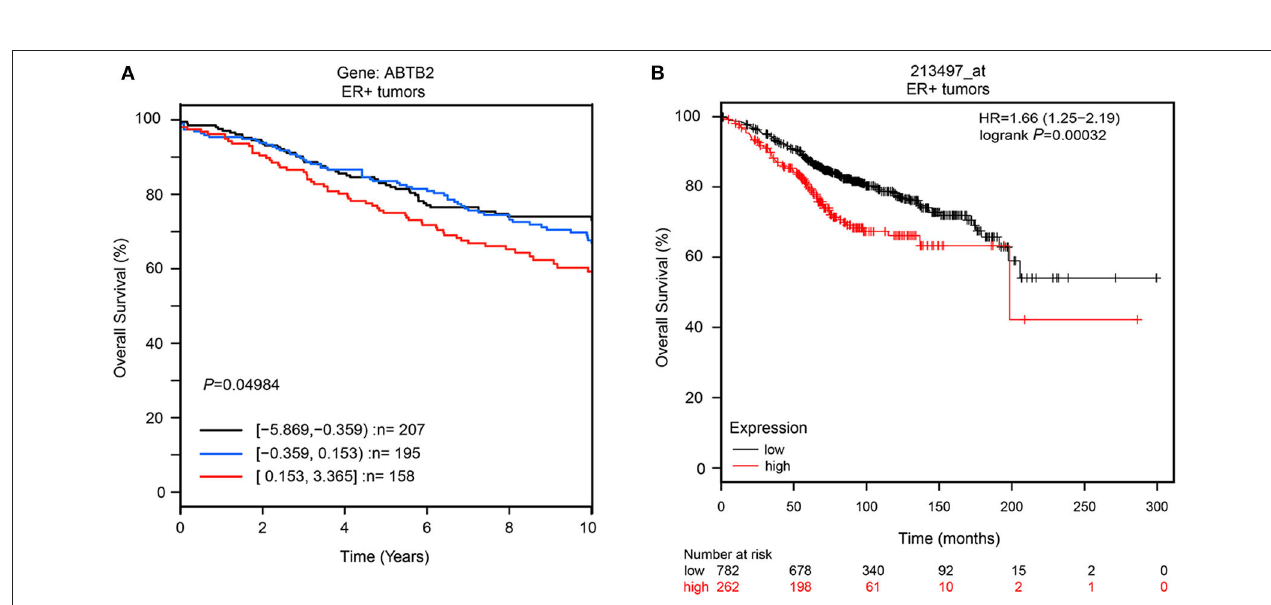
FIGURE 4 | The overall survival in different expression of ABTB2 in ER-positive breast cancer. We obtain data from two different published database. ABTB2 expression correlated with overall survival in 560 ER-positive breast cancer patients through GOBO Gene Set Analysis, P = 0.049 (A) ; Patients with high expression of ABTB2 has significantly shorter overall survival than those with low expression (B) P = 0.0003.